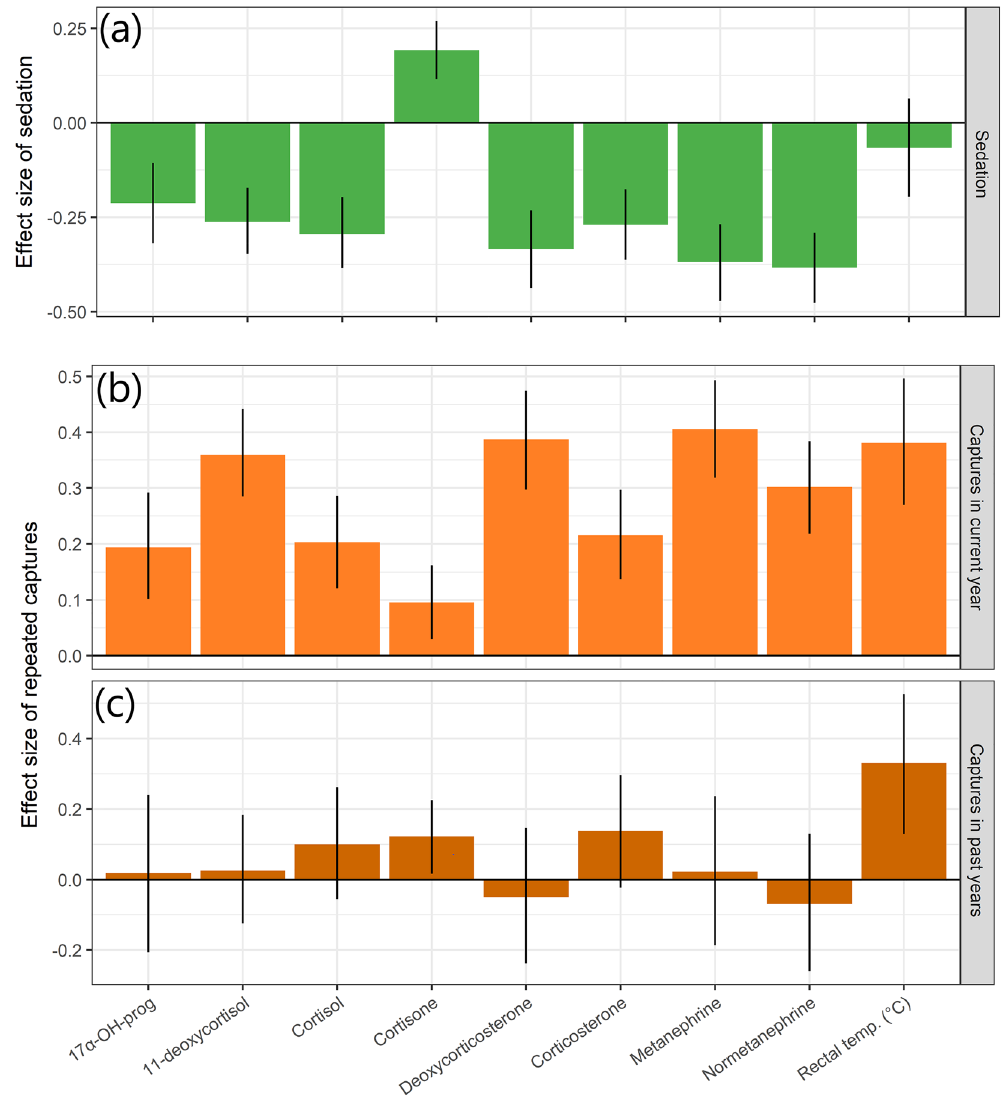
Figure 4. Scaled effect sizes of sedation during handling ( a ), number of captures in current year ( b ) and number of captures in past years ( c ), on each measured variable describing the acute stress response during capture in female Svalbard reindeer. A bar above zero indicates an increased stress response with increasing capture frequency, while a bar below zero indicate a reduced response. The 95% credible intervals are shown as vertical lines; non-significant results are indicated by lines crossing